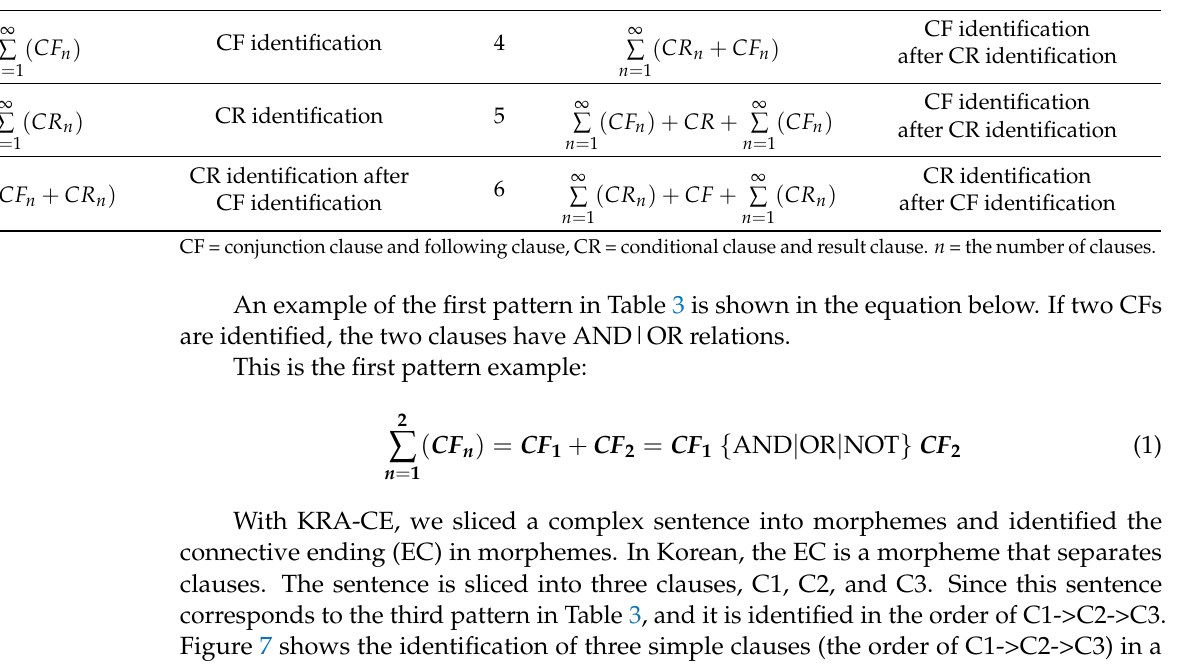
Figure 6. Corpus normalization.